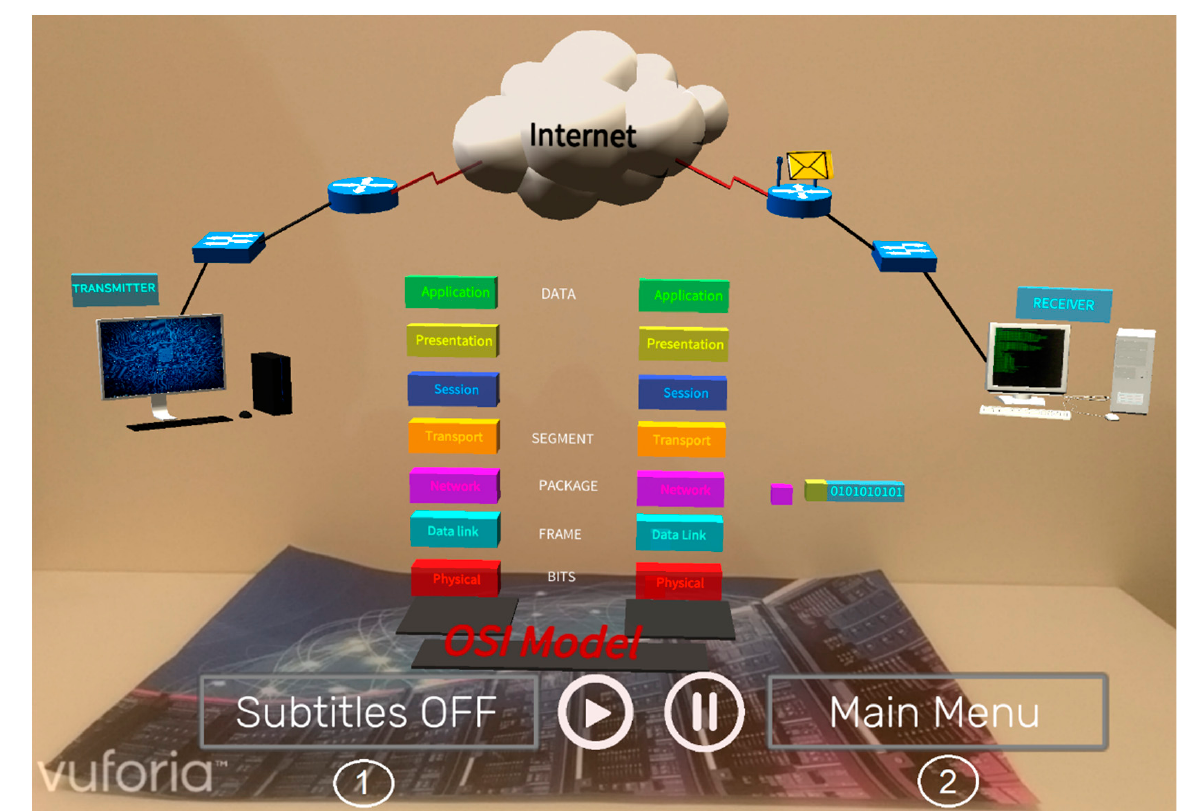
Figure 2. Level 1. ISO/OSI model shown in NetAR. The application has the option to turn subtitles on and off for the explanation of the model shown ( 1 ); the user can start and pause the animation with the buttons placed on the screen. There is also an option to return to the main menu and access the other levels of NetAR ( 2 ).